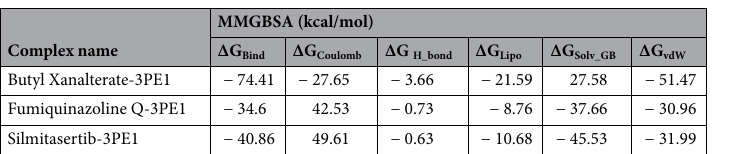
Table 5. Post simulation Components of binding free energy for protein–ligand complexes estimated using MM-GBSA